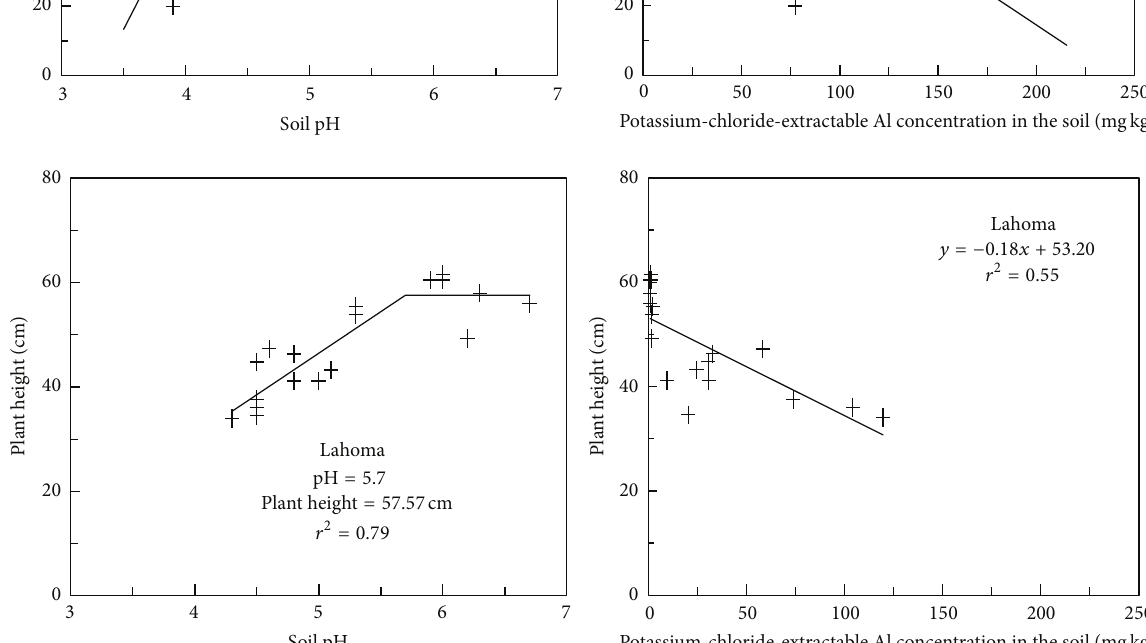
Figure 5: Sunflower plant height as a function of soil pH and potassium-chloride-extractable aluminum concentration (mgkg −1 ) in the soil at Perkins, Haskell, and Lahoma, Oklahoma, in